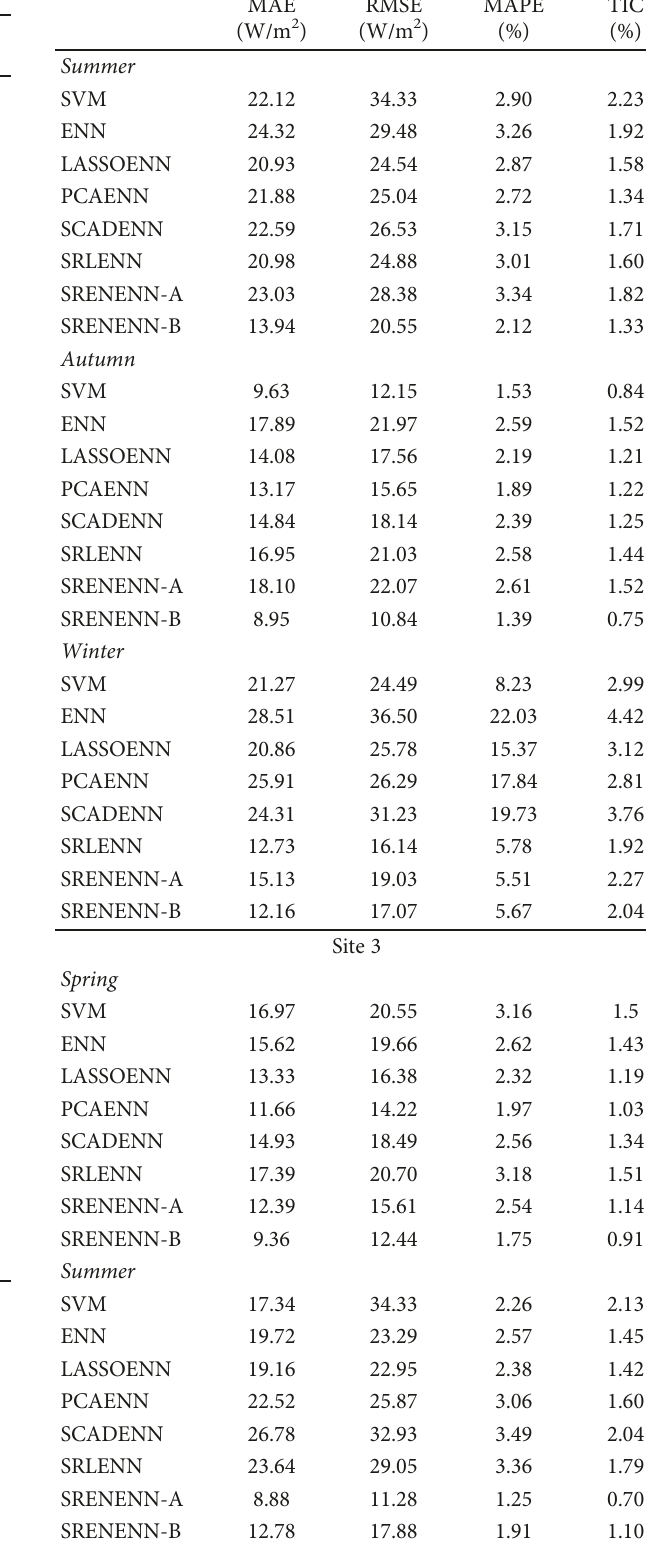
Table 5: Mean forecasting errors of forecasting models for each season at Site 1, Site 2, and Site